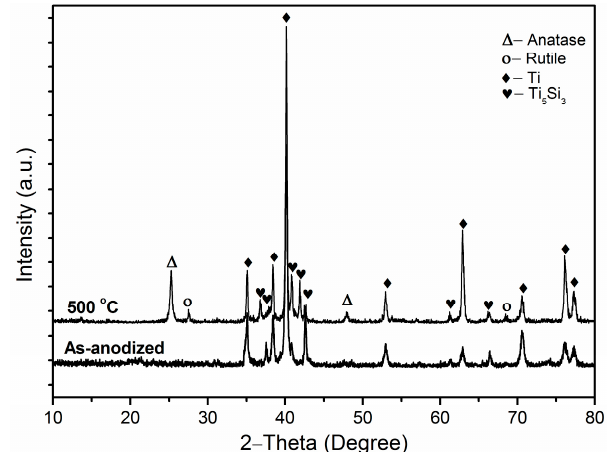
Figure 3. XRD patterns of the as-anodized and the annealed Ti-Ni-Si-O nanostructures.